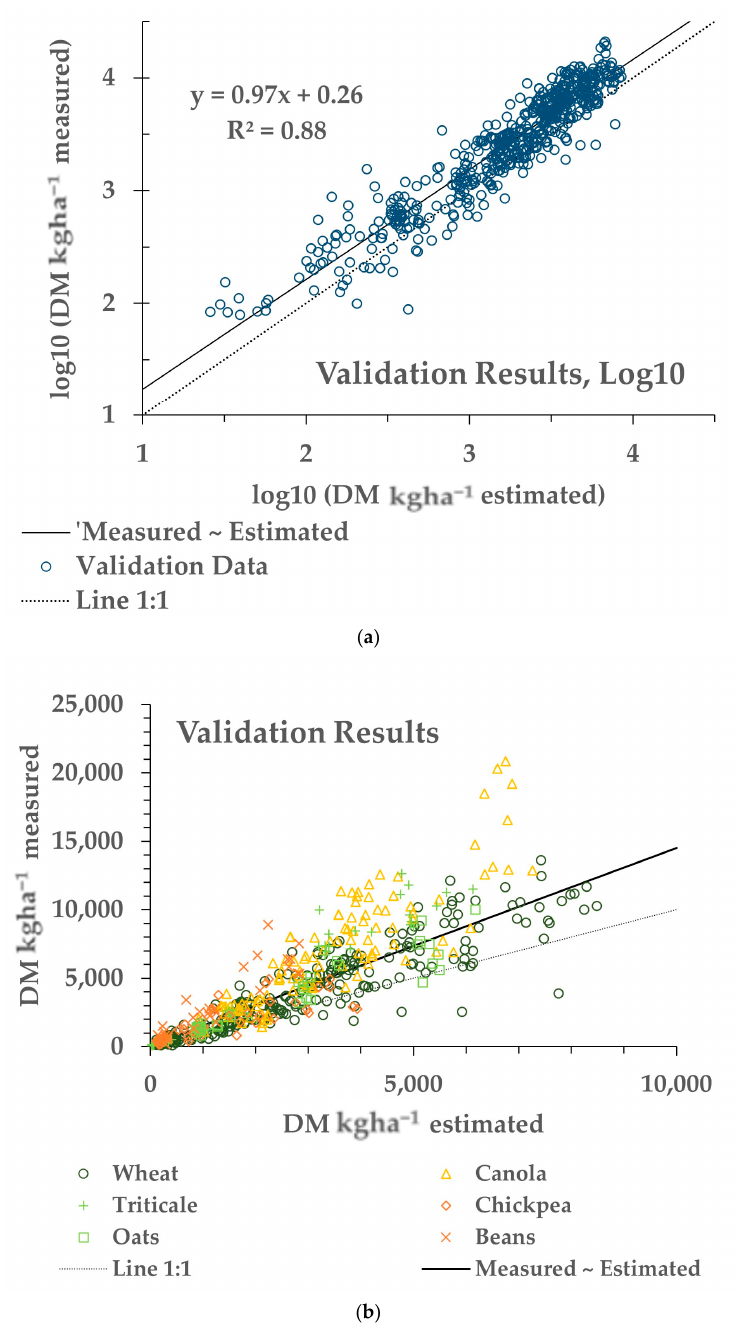
Figure 5. Results from a validation dataset (N = 550), not utilised for the training results shown in Table 2. ( a ) Measured versus estimated AGB in log10 transformation. The solid line indicates the fitted relationship, and the small dashed line indicates the 1:1 relationship between the modelled and measured AGB. ( b ) The same results transformed back to the original space. The solid and dashed lines indicate the fitted and 1:1 relationships, respectively. The symbols indicate the crop